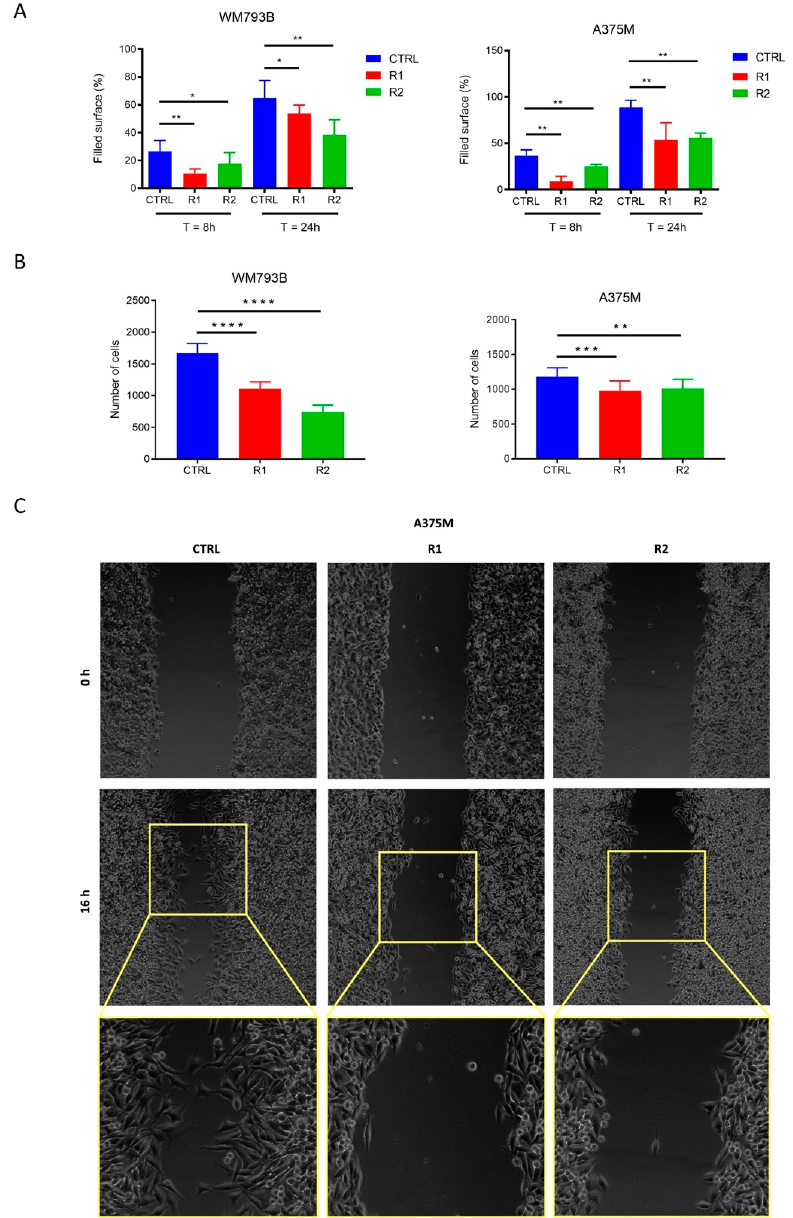
Figure 4. Migration of parental and resistant WM793B and A375M melanoma cells. For the wound healing assay ( A ), parental cells (CTRL) and vemurafenib-resistant sublines (R1 and R2) were imaged at the time of causing the wound and 8 and 24 h after. The results are shown as a filled area at a given time point. The mean and standard deviation of 12 measurements for each sample and time point are shown. For the culture insert assay ( B ), parental cells (CTRL) and vemurafenib-resistant sublines (R1 and R2) were imaged one hour after seeding in the upper chamber. The results are presented as the number of cells passing the membrane from the upper to the lower chamber. The mean and standard deviation of six measurements per sample are shown. The Mann–Whitney test (GraphPad Prism v. 7.04) was used for statistical analysis. Statistically significant results are marked by an asterisk (*). A p -value less than 0.05 is flagged with one star (*), a p -value less than 0.01 is flagged with two stars (**), a p -value less than 0.001 is flagged with three stars (***), and if a p -value is less than 0.0001, it is flagged with four stars (****). Micrograph of the wound healing assay of A375M melanoma cells after 16 h filmed with video microscopy ( C ). The parental A375M cells (CTRL) close the wound by single-cell migration, whereas the vemurafenib-resistant cells (R1 and R2) exhibit collective